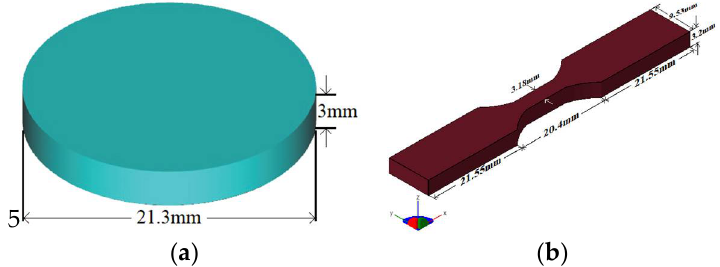
Figure 1. Testing substrates designed in FreeCAD. ( a ) Cylindrical geometry and ( b ) test probe for tensile testing (ASTM D638-14 type V).